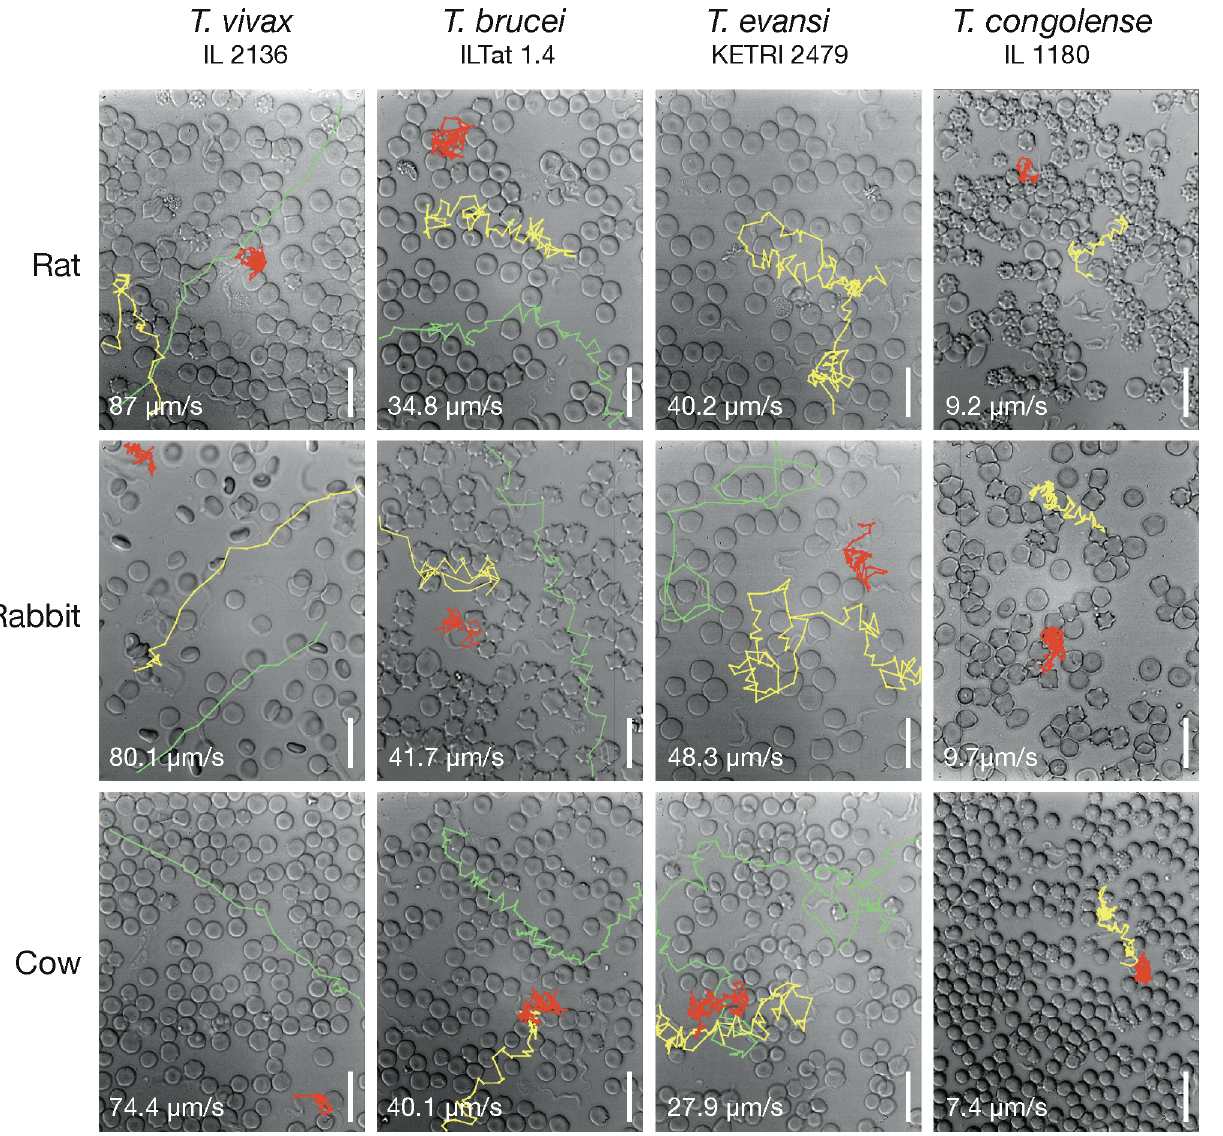
Fig 3. Representative examples of trypanosomes swimming in blood from different host animals. The images are stills of the corresponding S6 Video. Videos were captured with a frame rate of 500 fps. The swimming paths were traced using the Fiji plugin MTrackJ [26]. The trajectories of one example each of tumbling (red), intermediate (yellow) and persistent (green) swimmers are shown. The numbers are maximum speeds (n = 20).